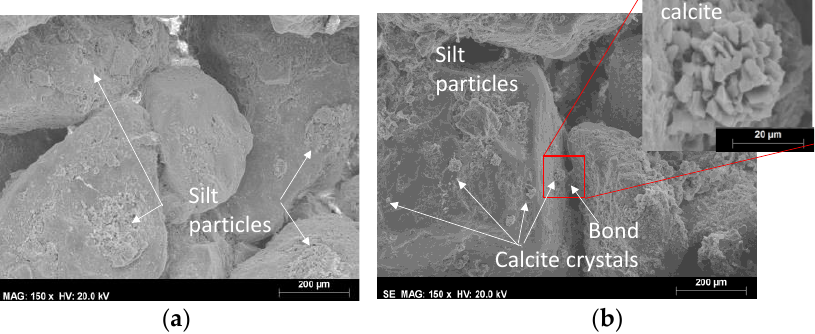
Figure 4. SEM images of the soil: ( a ) before treatment; ( b ) after treatment, showing calcite crystals.